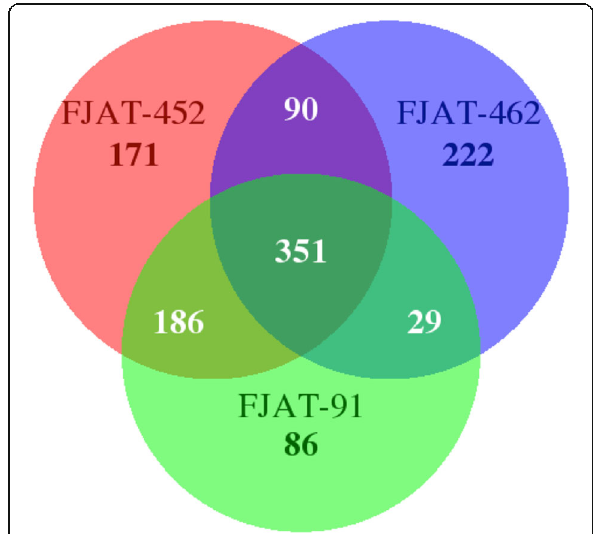
Fig. 4 Venn diagram of T3E gene variants identified in FJAT-91, FJAT-452 and FJAT-462 when compared to the reference